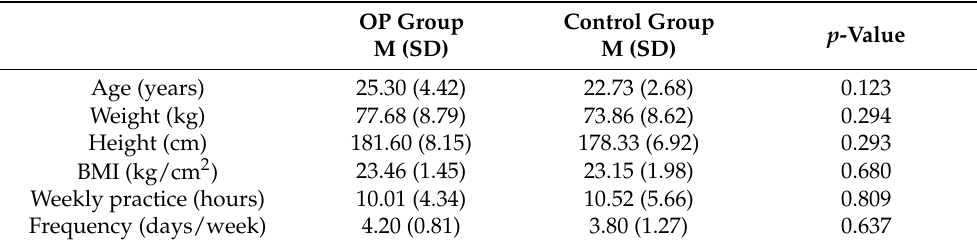
Table 2. Demographic and sport-related